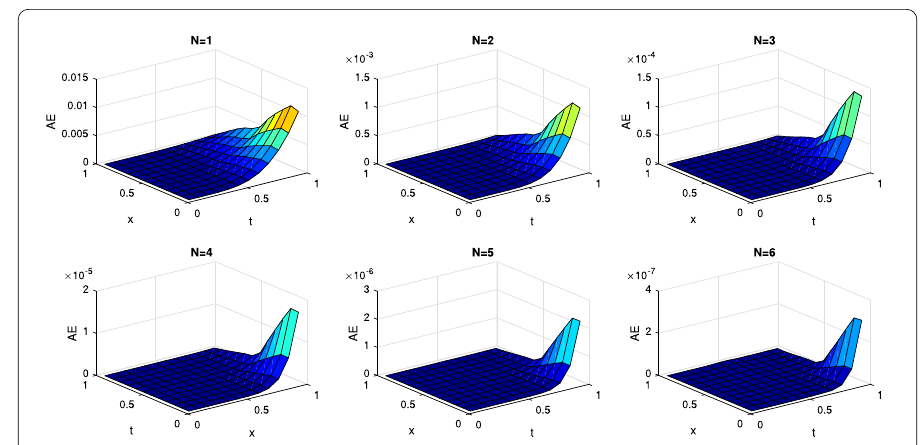
Figure 3 Absolute errors(AE) for different values of N , α = 1, k = 2, M = 6 in Example 3